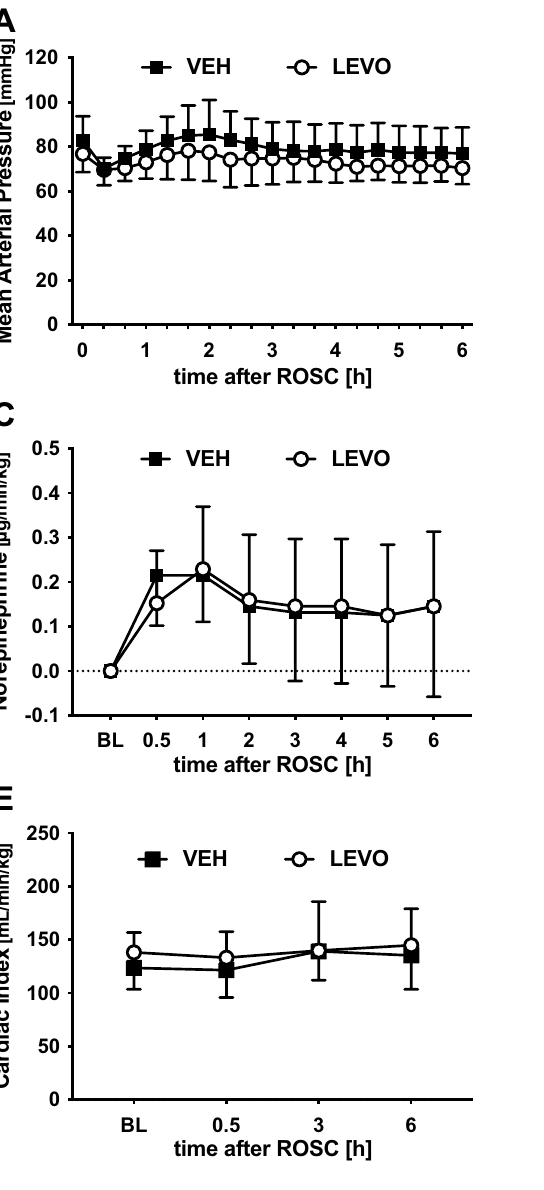
Figure 1. Cardiac index (CI), mean arterial pressure (MAP), and key experimental parameters. To determine the influence of cardiac arrest and levosimendan on key cardiovascular parameters and post-CPR management, MAP ( A ) and heart rate ( B ) were recorded before and after ROSC. MAP was maintained with ( C ) norepinephrine and ( D ) balanced electrolyte solution infusion. ( E ) As a general marker for cardiac function, CI was determined before and 0.5, 3, and 6 h after ROSC using the PiCCO System. ( F ) As a general marker for tissue hypoxia, blood lactate was quantified at the same time points. Levosimendan did not influence any parameter compared with vehicle treatment. BL baseline, VEH vehicle, LEVO levosimendan. Statistics: repeated measures two-way ANOVA, followed by Šidák’s multiple comparisons test; data are presented as means ±